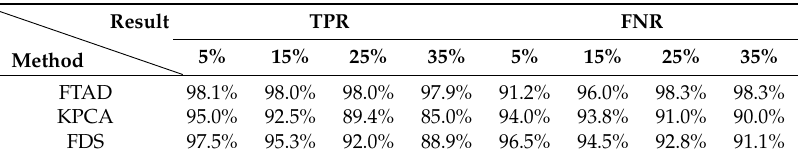
Table 3. FTAD vs. KPCA and FDS.